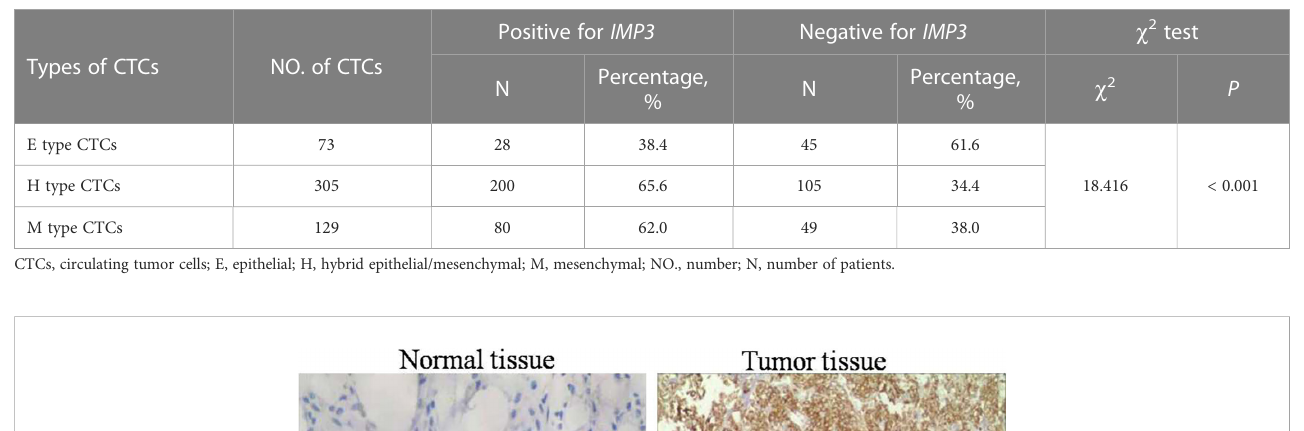
TABLE 4 The expression rates of the IMP3 gene in different types of CTCs.